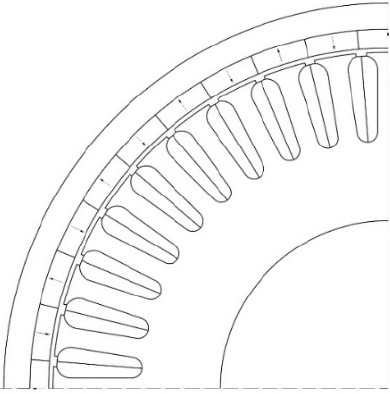
Figure 6. The cross ‐ section of a flat core construction proposed in this article. Figure 6. The cross-section of a flat core construction proposed in this article. The coils cover individual teeth and are connected alternately in a series. In the de-energized state of the coils, each pair of teeth is influenced by the same magnetomotive force (MMF) of magnets as each U core. Assuming no leakage flux and the linearity of the cores, the flux in the teeth should remain at the same level as the flux in the U cores. Under these conditions, in the circuit made of coils, where the total number of turns is the same as in the ring winding in Figure 1, a similar electromotive force (EMF) value should be induced while the rotor is moving. The leakage flux, however, reduces the flux in the U cores as it moves away from the magnets; thus the EMF in the circuit composed of the coils around the teeth will be higher than in the winding loop of the